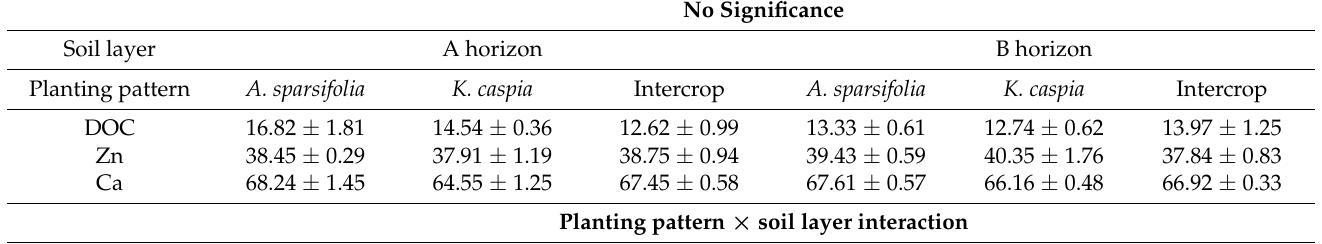
Table 1. Soil physicochemical properties in two soil layers of A. sparsifolia and K. caspia monocultures and their